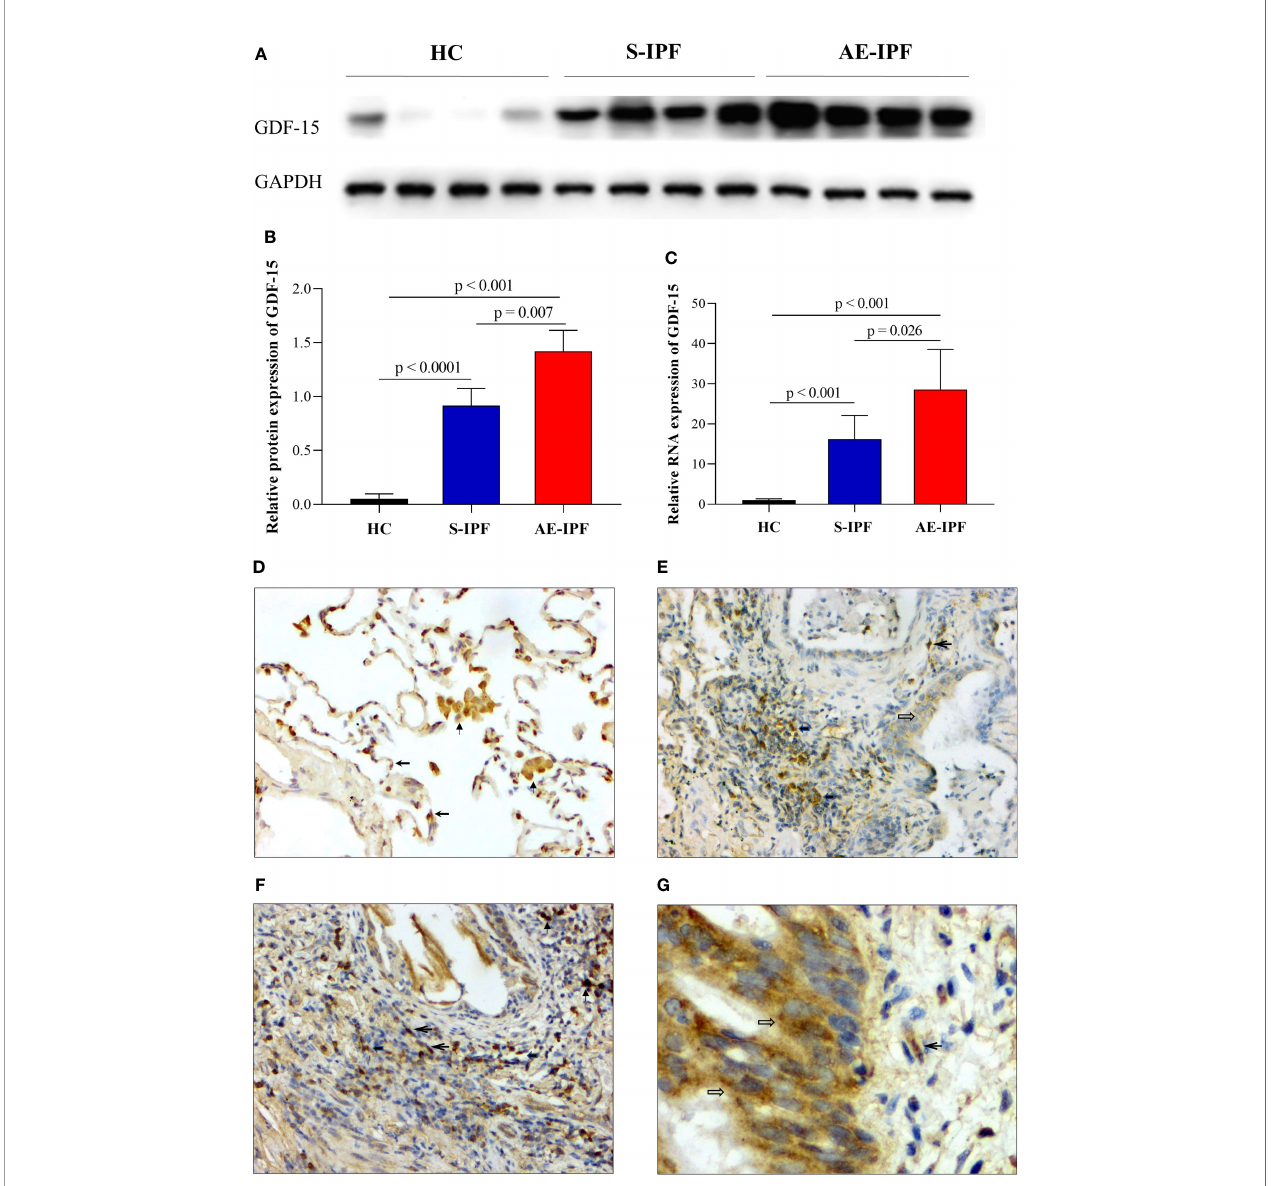
FIGURE 2 | GDF-15 expression in the lung of IPF patients. (A) GDF-15 protein expression in the lung tissues of subjects with HC, S-IPF, and AE-IPF by WB. (B) The quanti fi cation of A showed that the protein expression of GDF-15 was signi fi cantly upregulated in AE-IPF patients compared with S-IPF subjects and HCs (p = 0.007 and p < 0.001, respectively). (C) GDF-15 mRNA expression in the lung of AE-IPF patients was signi fi cantly increased compared with HC, S-IPF cases by RT-PCR (p < 0.001 and p < 0.026, respectively) (n = 4, each group). (D – G) GDF-15 expression in the lung measured by IHC. (D) The moderately positive expressions of GDF-15 in the cytoplasm of type II AECs and macrophages in HC (IHC, ×200). (E) The moderately positive expressions of GDF-15 in in fl ammatory cells and macrophages in the alveolar septum and mild positive expressions in the bronchial epithelial cells and fi broblasts in S-IPF patients (IHC, ×200). (F) GDF-15 moderately positive expressions in in fl ammatory cells, macrophages, and fi broblasts in the interstitial spaces in AE-IPF case (IHC, ×200). (G) The moderately positive expressions of GDF-15 in the bronchial epithelial cells and fi broblasts in the same AE-IPF patient as Figure 2F (IHC, ×400). (Notes: macrophages ; type II AEC ; in fl ammatory cell ; bronchial mucosa epithelial cells ; fi broblast